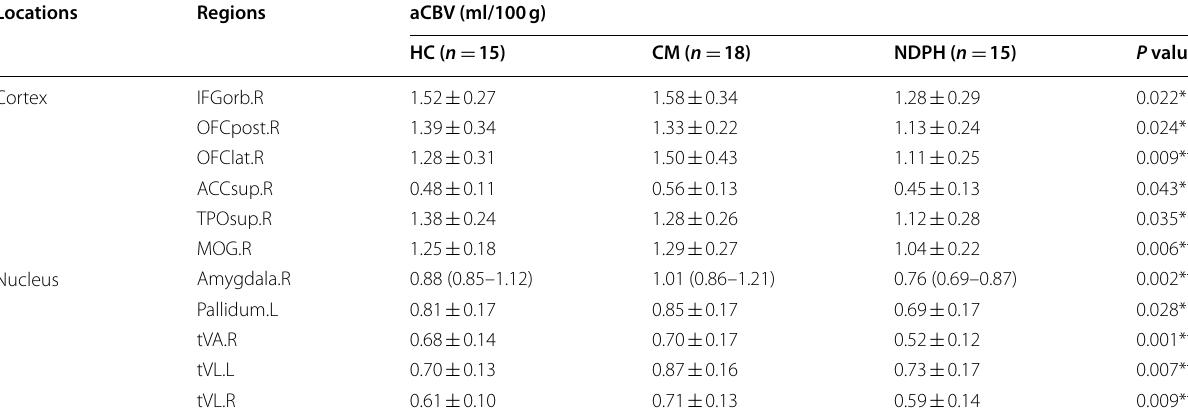
HC healthy control, NDPH new daily persistent headache, CM chronic migraine. IFGorb.R right inferior frontal gyrus pars orbitalis, OFCpost.R right posterior orbital gyrus, OFClat.R right lateral orbital gyrus, ACCsup.R right anterior cingulate cortex, supracallosal gyrus, TPOsup.R right superior temporal gyrus, temporal pole, MOG.R right middle occipital gyrus, Amygdala.R right amygdala, Pallidum.L left pallidum, tVA.R right thalamus, ventral anterior nucleus, tVL.L left thalamus, ventral lateral nucleus, tVL.R right thalamus, ventral lateral nucleus. * P <0.05, ** P <0.01